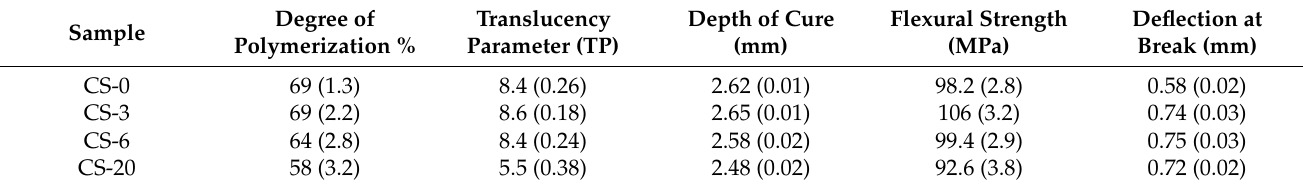
Table 2. Physical Properties of Composites.